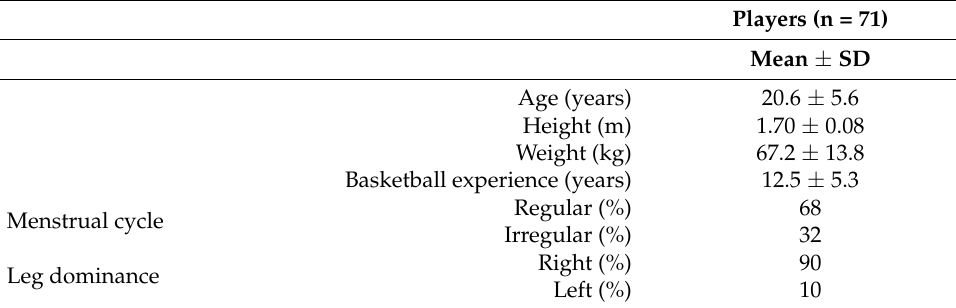
Table 1. Characteristics of female basketball